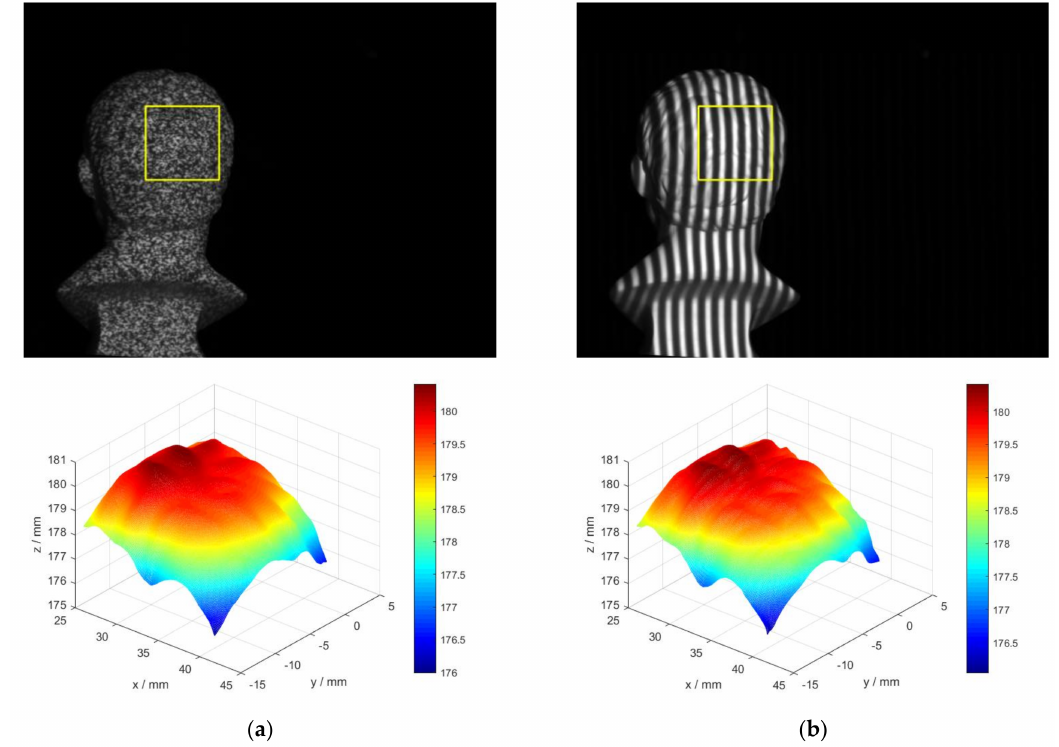
Figure 11. Rectified left image of head and reconstructed 3D data of the ROI marked by yellow rectangle: ( a ) Measured by IC-GN 2 under the convergence threshold of 0.1; and ( b ) Measured by three-frequency three-step structured